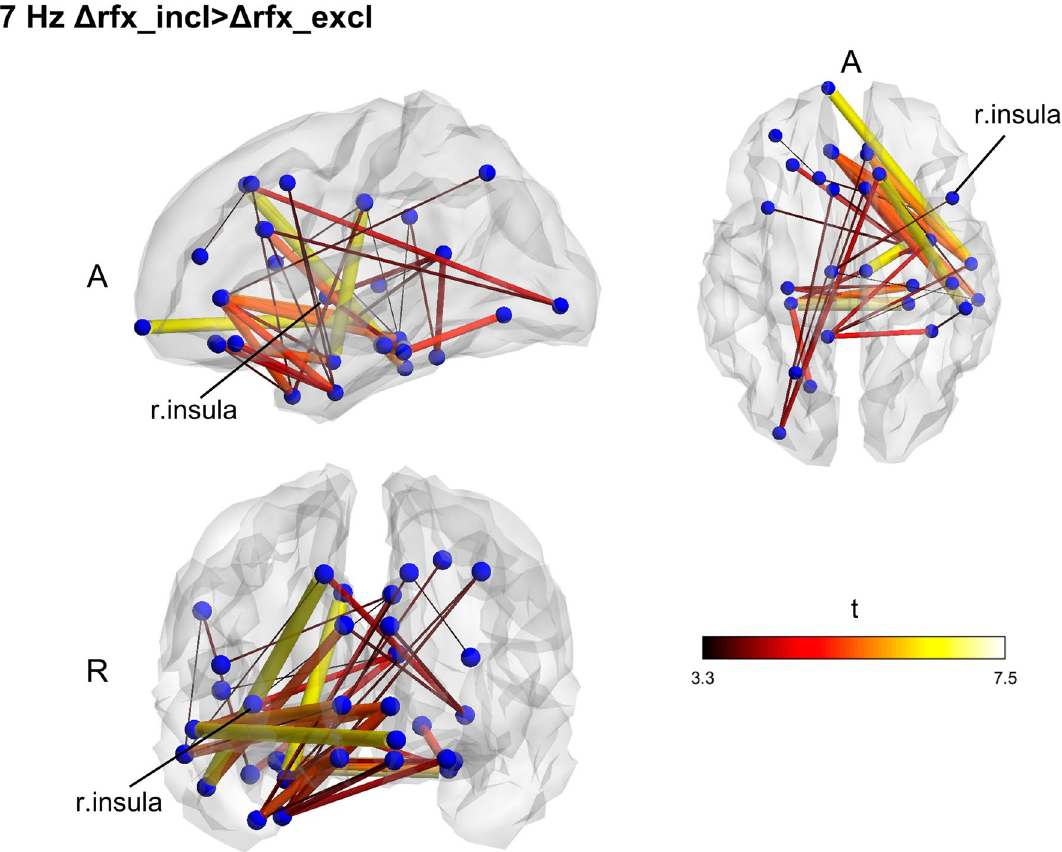
Figure 5. Within groups, functional connectivity comparison between exclusion and inclusion condition in post-treatment session. An opposite pattern was found for the Rifaximin group (Δrfx), displaying a higher functional connectivity network in theta during the inclusion condition. Again, the network is largely widespread across the brain. To note the presence of the insula again, size and color of the edges